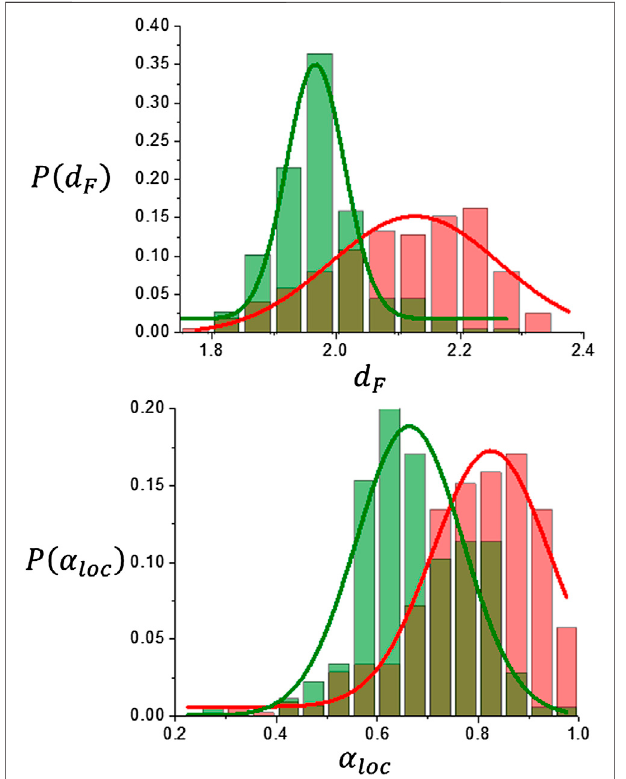
FIGURE 6 | Scaling analysis results for brain tumors. Distribution histograms for d F and α loc .